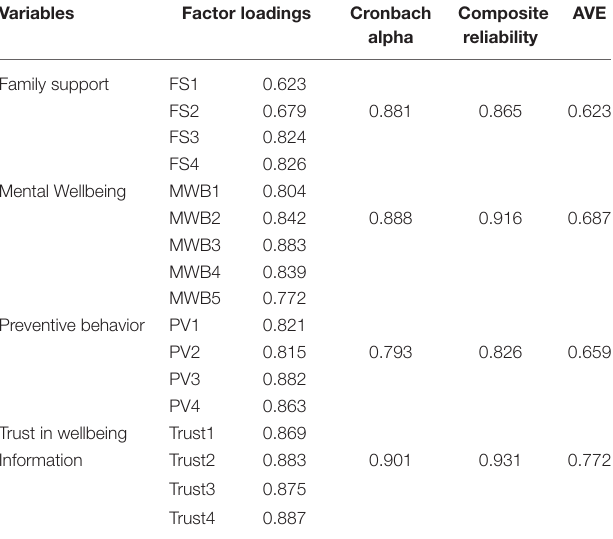
TABLE 2 | Convergent validity and